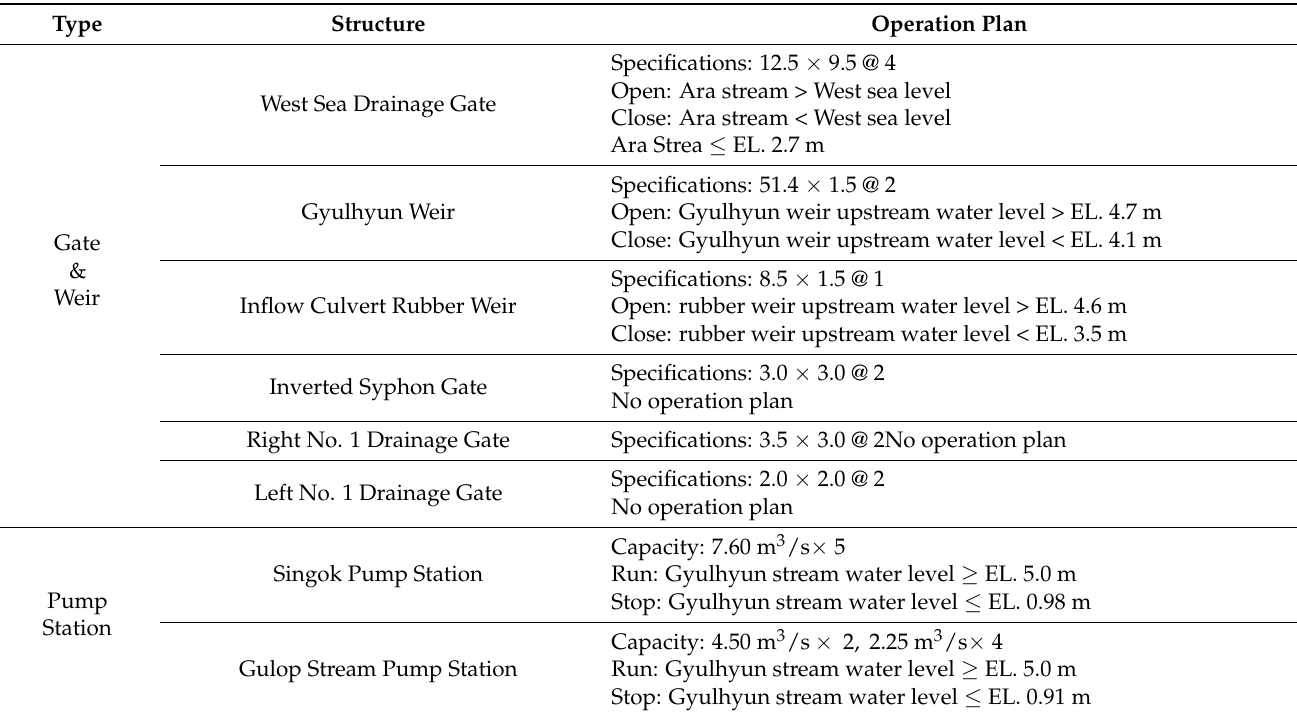
Table 2. Structural Specifications and Operation Plans.